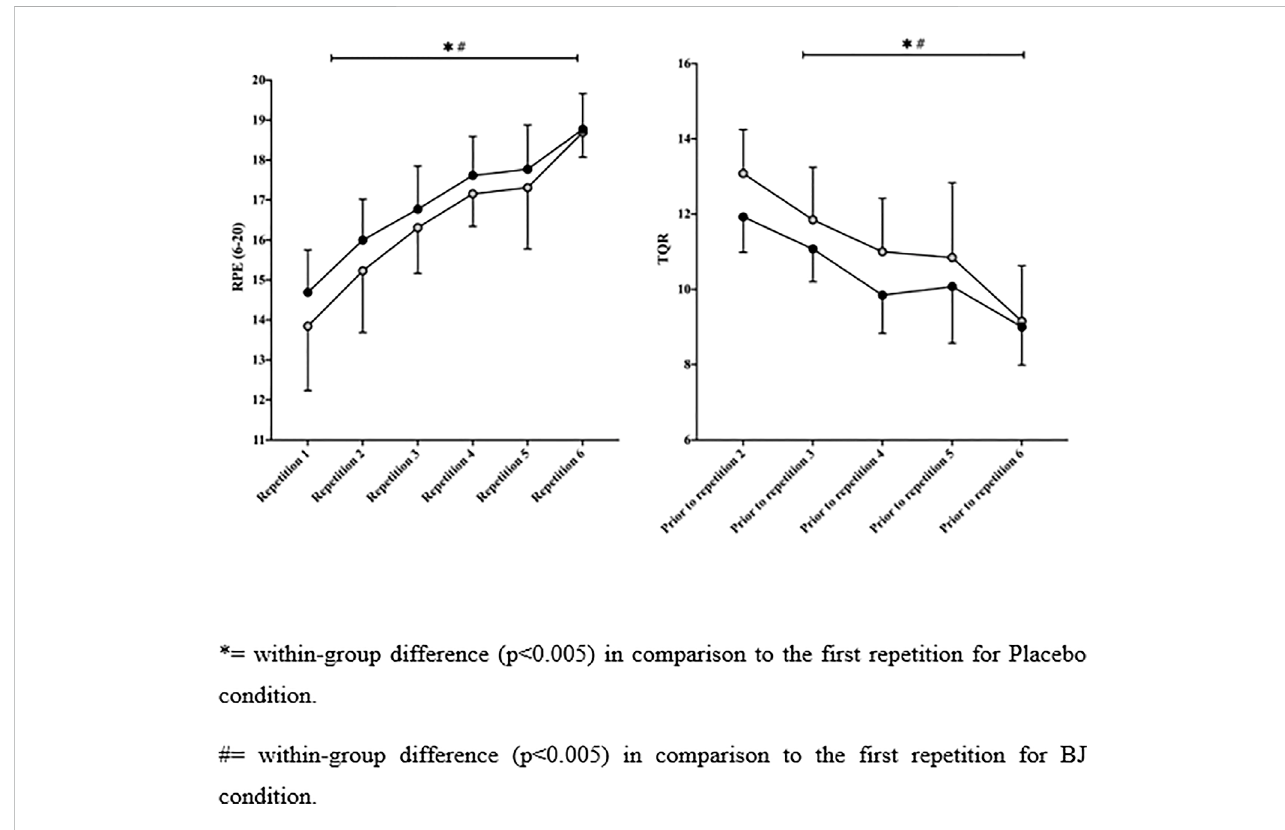
FIGURE 4 Rating of perceived exertion (RPE) and total quality recovery scale (TQR) responses after each 100-m sprint repetition for the beetroot juice (BJ) and placebo